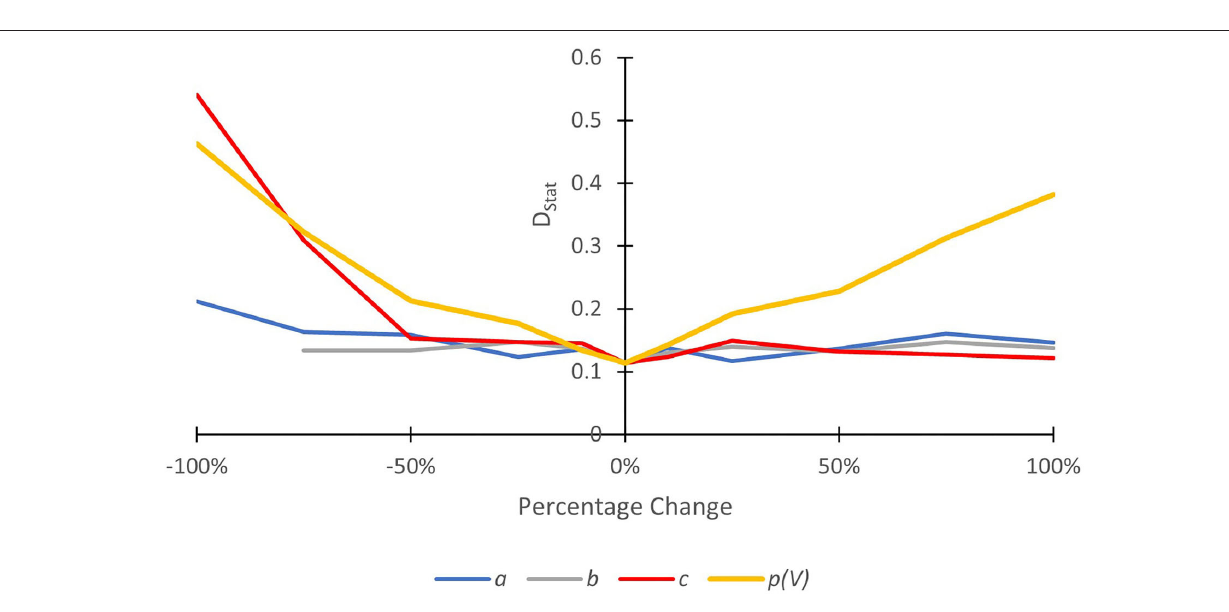
along channel banks is relatively minor. Further